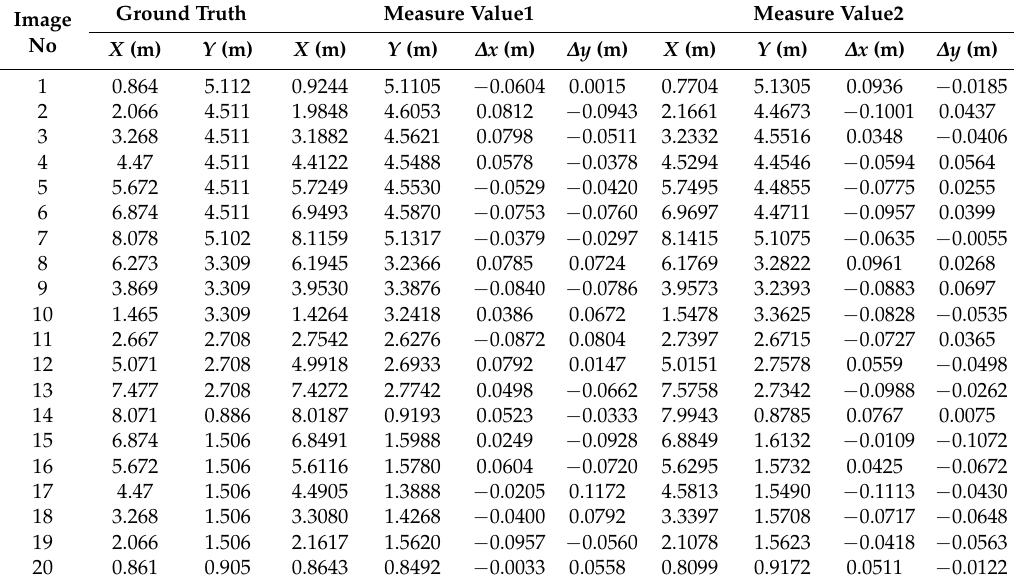
Table 2. Positioning accuracy of the Huawei P10 smartphone.